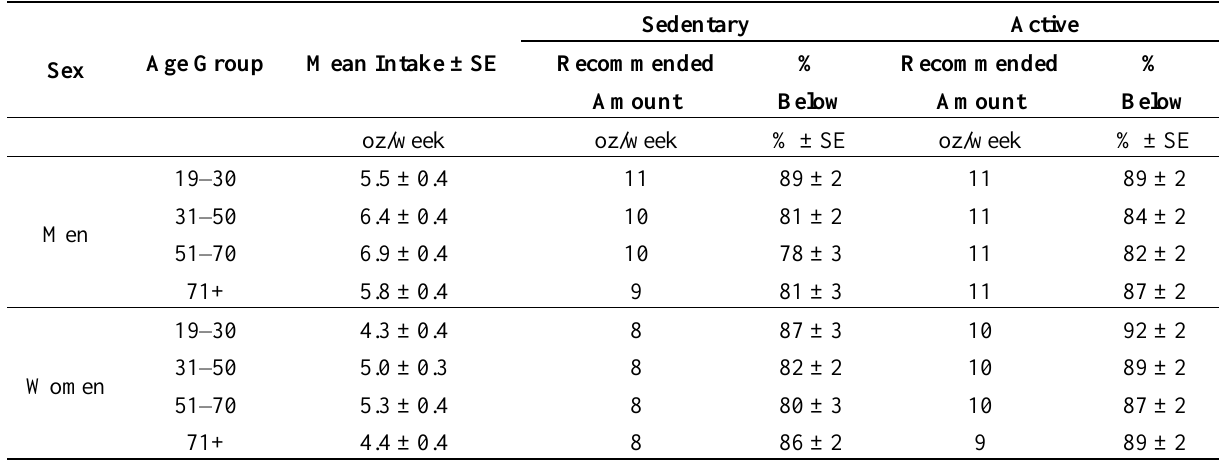
Table 3. Percentage of Americans not meeting seafood